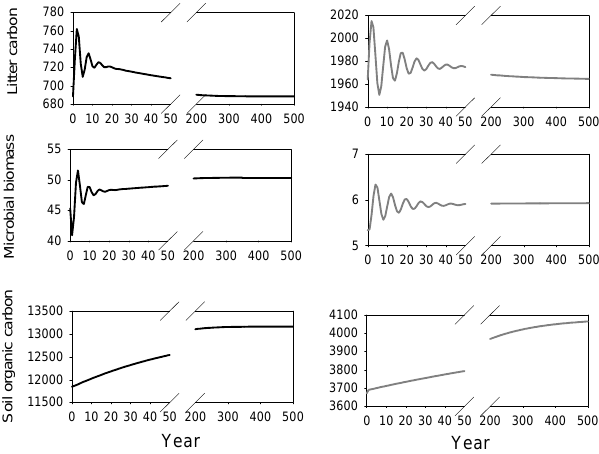
Fig. 3. Changes in litter carbon (upper panels), microbial biomass Figure 3. Changes in litter carbon (upper panels), microbial biomass (middle panels) or soil organic 777 (middle panels) or soil organic carbon (lower panels) following a carbon (lower panels) following 10% reduction in the initial pool sizes in microbial biomass and soil 778 10% reduction in the initial pool sizes in microbial biomass and organic carbon at time t=0 from their respective equilibrium pool sizes for the three-pool soil carbon 779 soil organic carbon at time t = 0 from their respective equilibrium model. The left three panels were for soil temperature of 15 o C and the right three panels for soil 780 pool sizes for the three-pool soil carbon model. The three panels on the left are for soil temperatures of 15 ◦ C and the right panels for temperature of 35 o C. The unit is g C m -2 for all pool sizes (0 – 100 cm soil depth). 781 soil temperatures of 35 ◦ C. The unit (gCm − 2 ) is the same for all pool sizes (0–100cm soil 782